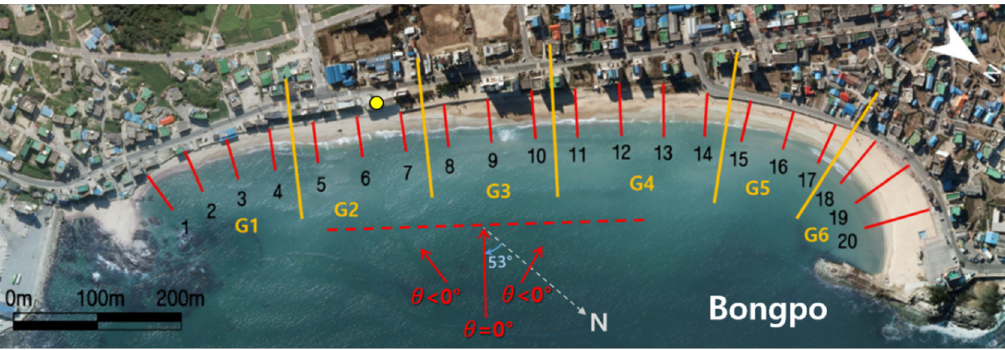
Figure 3. Clustered sectors along Bongpo Beach.